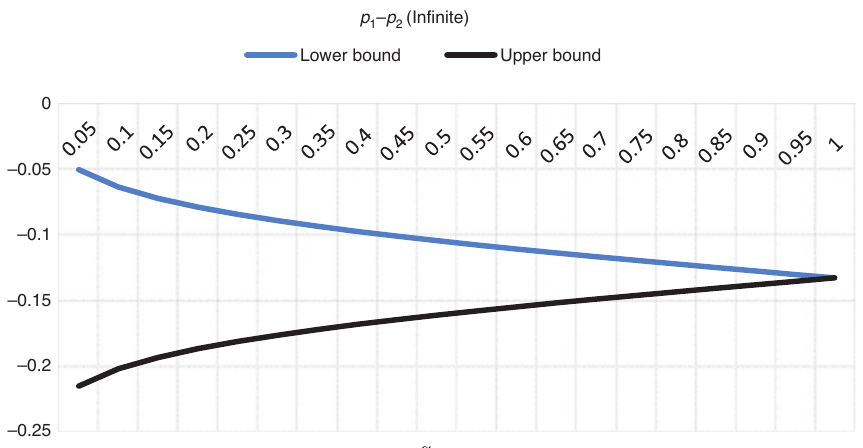
Figure 4: Confidence Intervals of Differences in Infinite Population